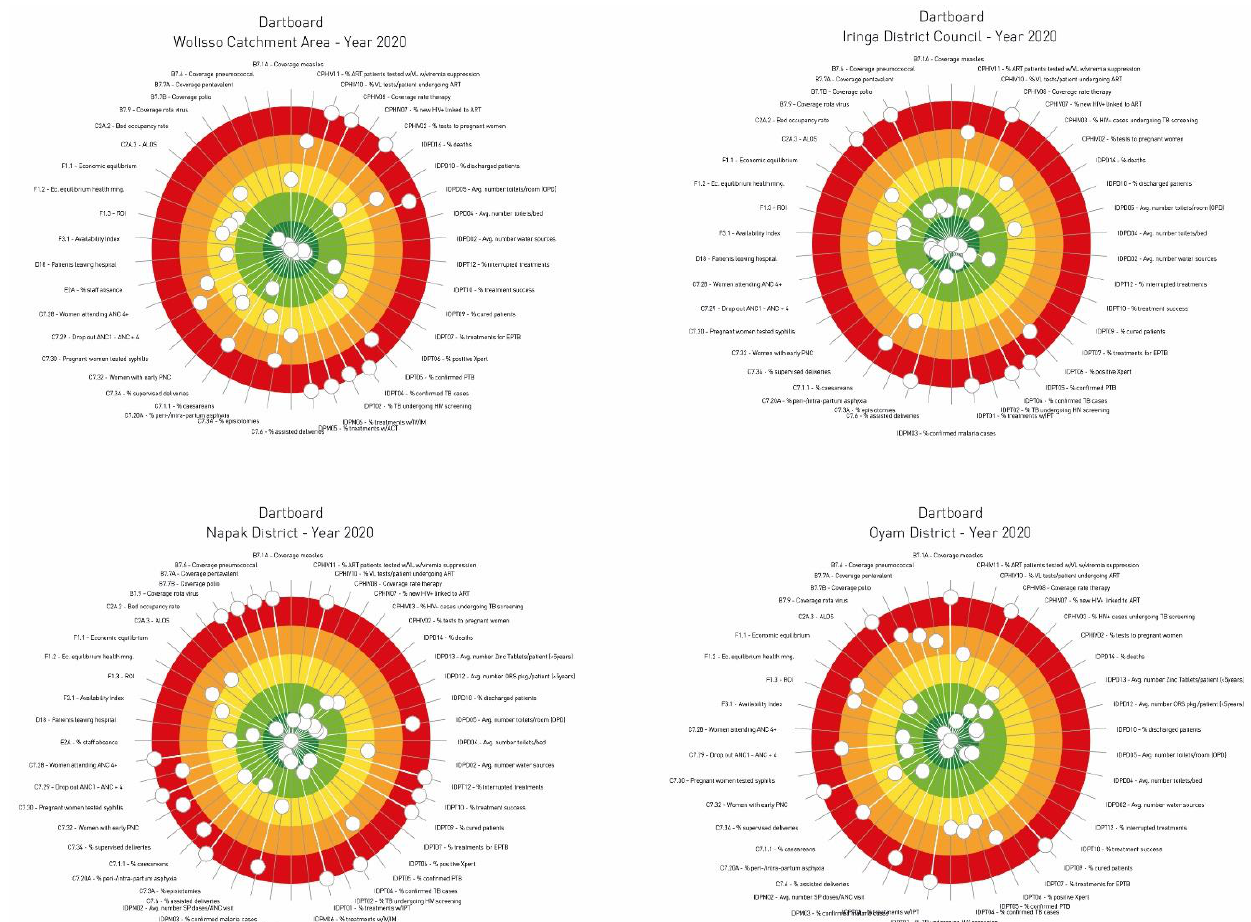
Figure 2. The four dartboards related to the performance of the health districts.